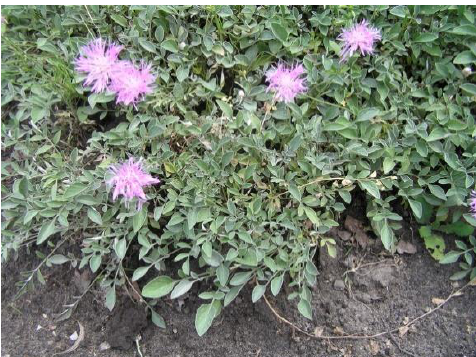
Figure 5. Psephellus bellus in the Garden of Department and Division of Practical Cosmetology and Skin Diseases Prophylaxis.